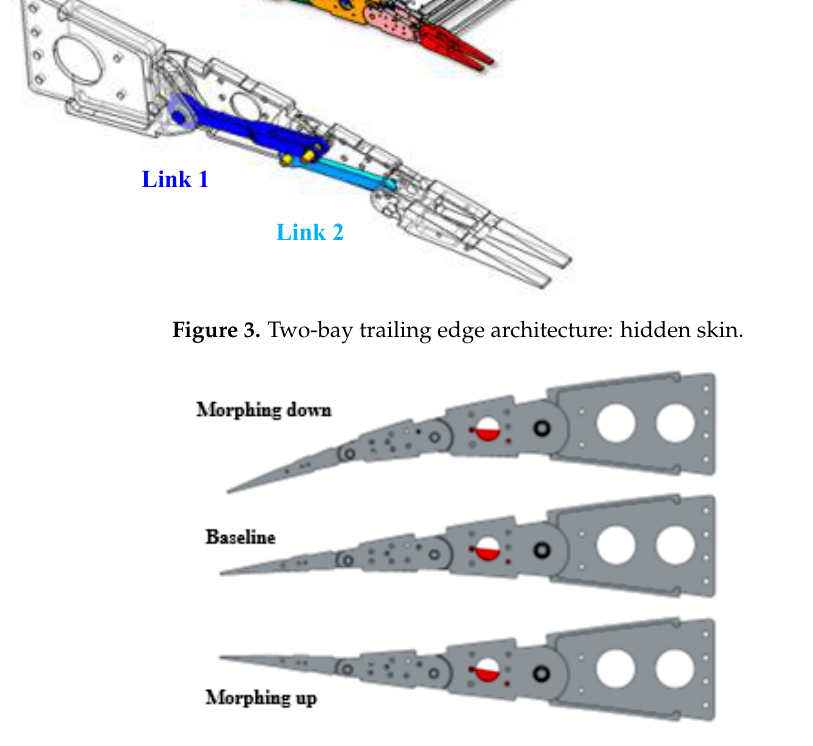
Figure 4. Trailing edge morphing shapes.